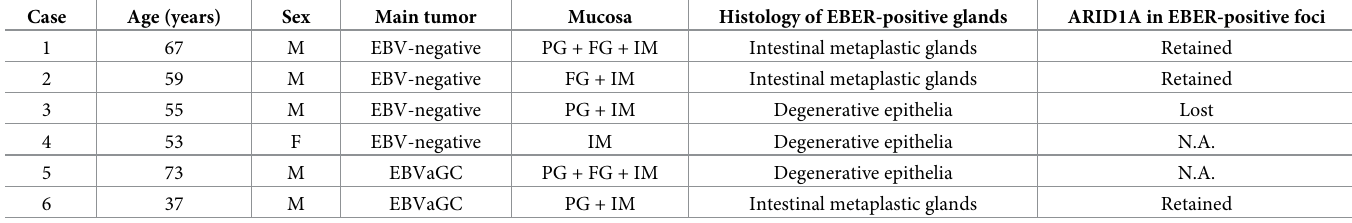
Table 1. Characteristics of EBER-positive non-tumorous glands in the background gastric mucosa.